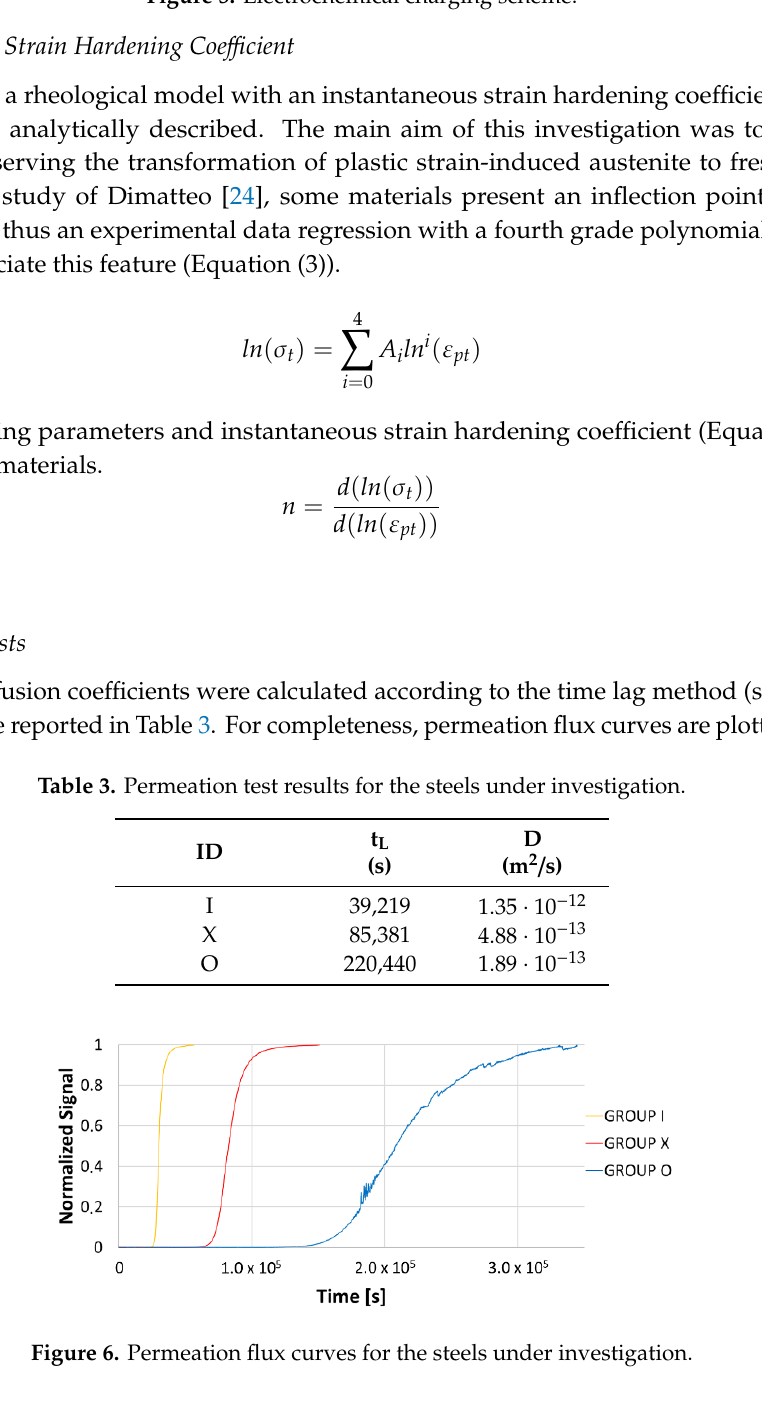
Figure 6. Permeation flux curves for the steels under investigation.